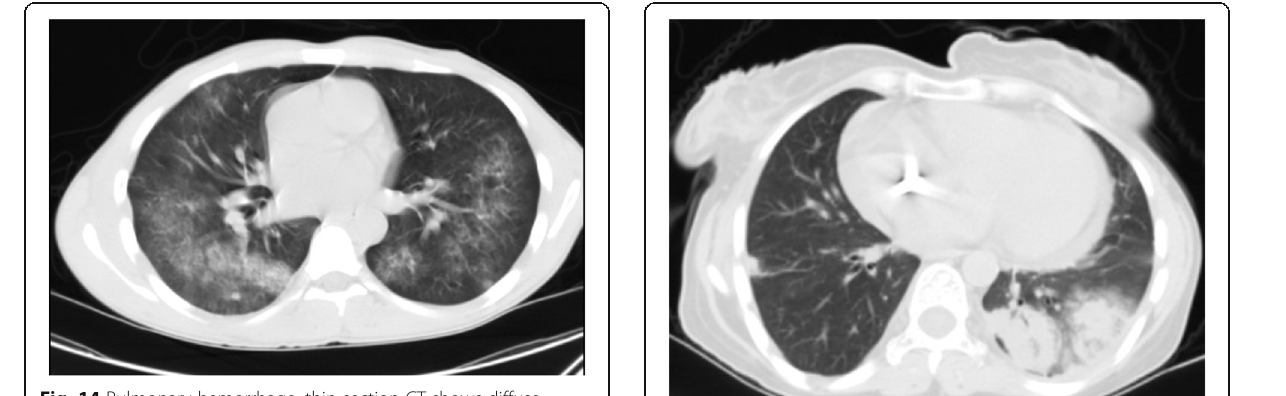
Fig. 14 Pulmonary hemorrhage: thin section CT shows diffuse bilateral parahilar GGO without round